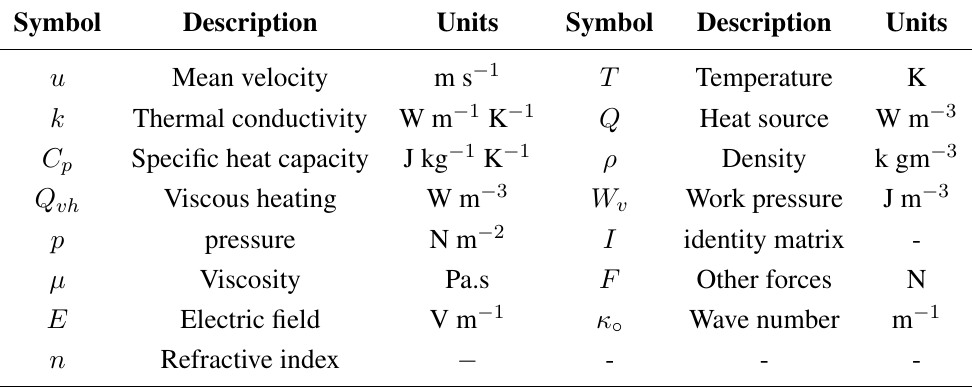
Table 1. Parameters used in the theory and modeling of the